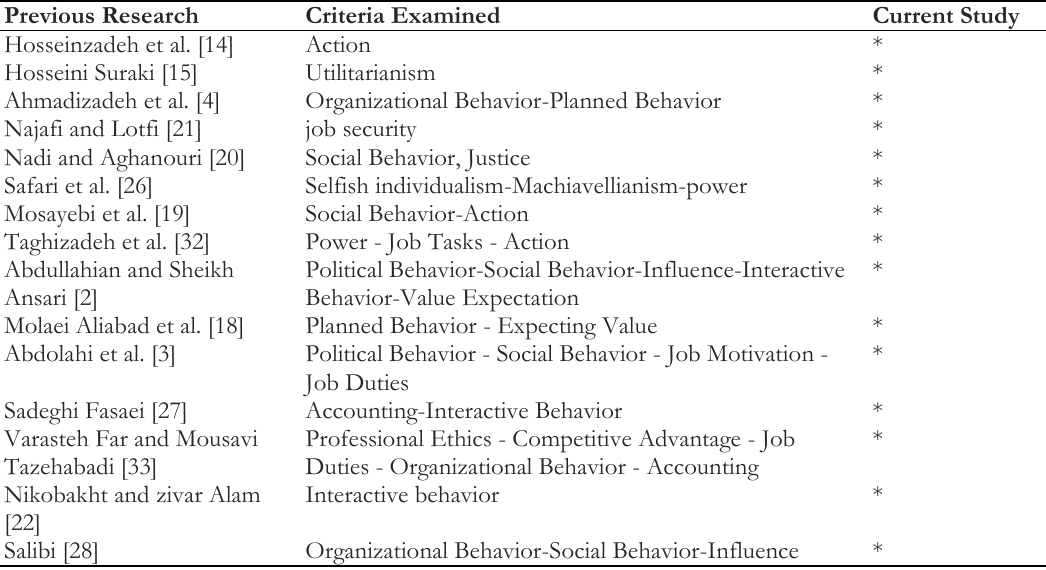
Table 6. Comparison with previous